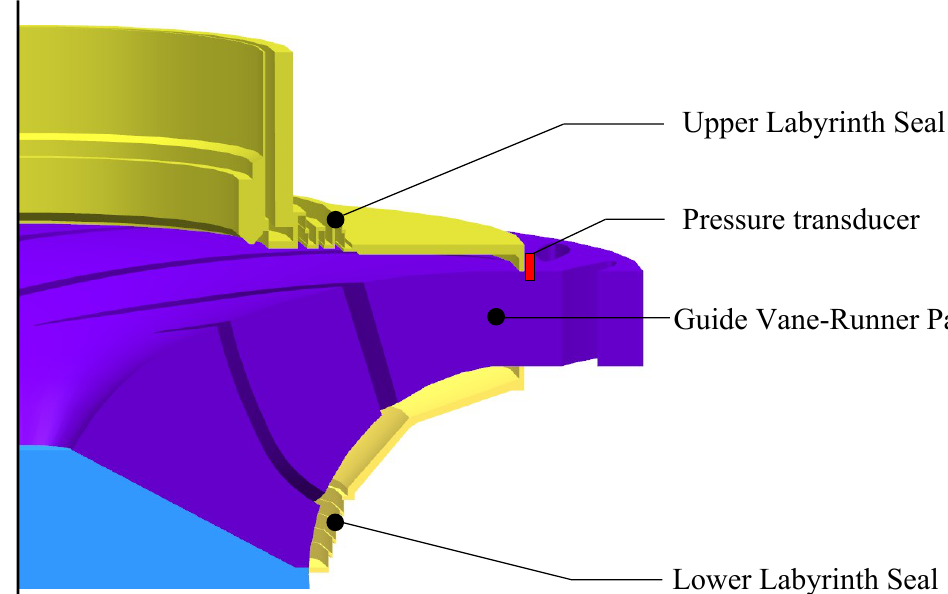
Figure 2. Pressure transducer location in the sectional view of the flow channel.